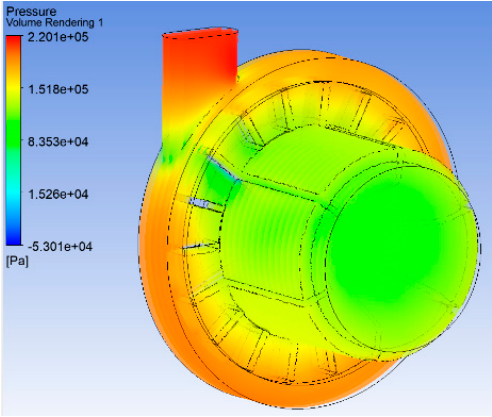
Figure 7. Pressure schedules of the pumped liquid for simulation 6. When the simulations were complete, positional tests were performed with the fol- lowing assumptions: free liquid inlet to the pump from the main tank (control throttle “c” opening 100%); outlet pressure control by means of control damper “d”. The maximum pressure (Figure 7) was small, approx. 1.2 bar (2.201 × 10 5 Pa) and it would have a low impact on the durability and sealing of the pump